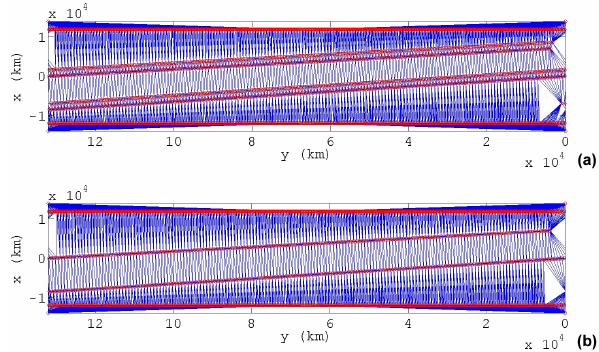
Fig. 5. Triangulations used for reconstruction. Each plot shows the triangles (blue lines) and the position of boundary points and measurement points (red circles). The bondary points are located on the top and bottom horizontal lines of red circles, as well as in the four corners: the other lines of red circles are the spacecraft tracks in the comoving xy domain. The tracks of spacecraft 1 and 3, and of 2 and 4, respectively, nearly coincide and are hard to distinguish on the plots. (a) Triangulation for 4-spacecraft data. (b) Triangulation for 2-spacecraft data